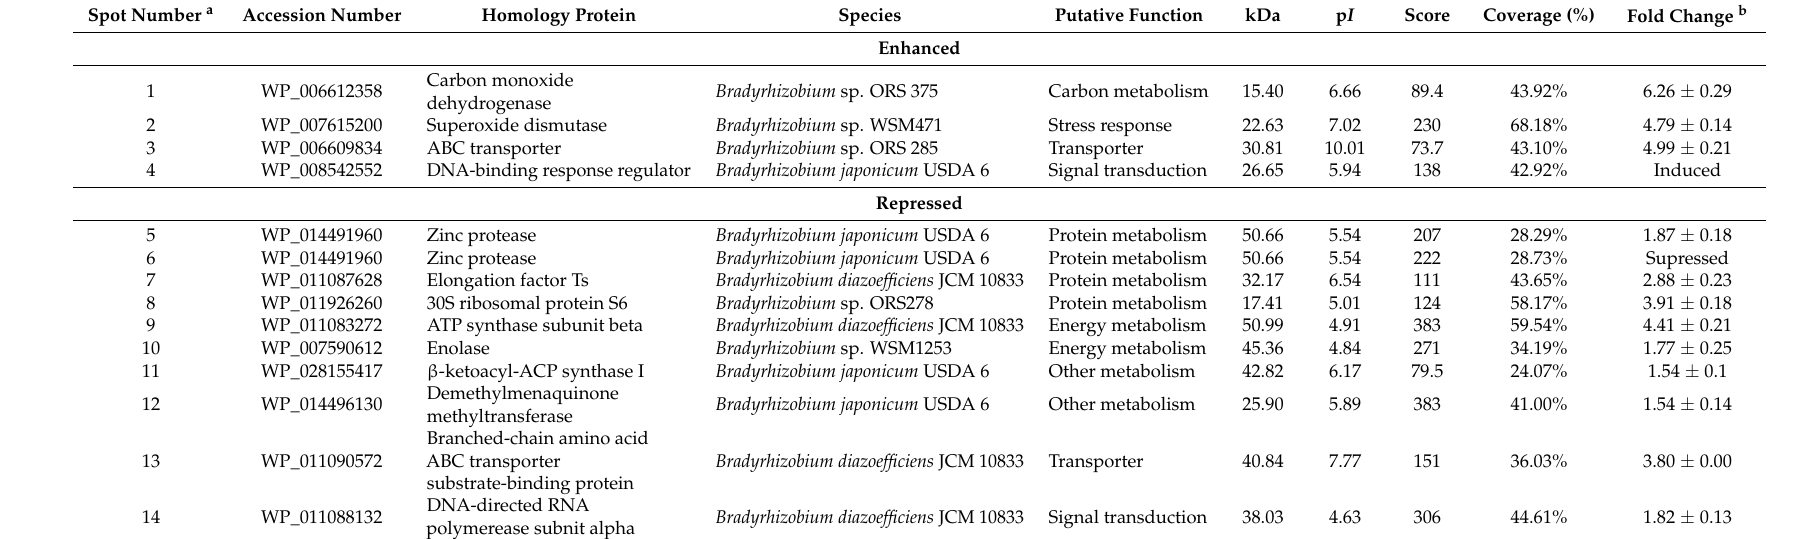
Table 2. Identification of salt stress regulated proteins through MALDI TOF/TOF MS